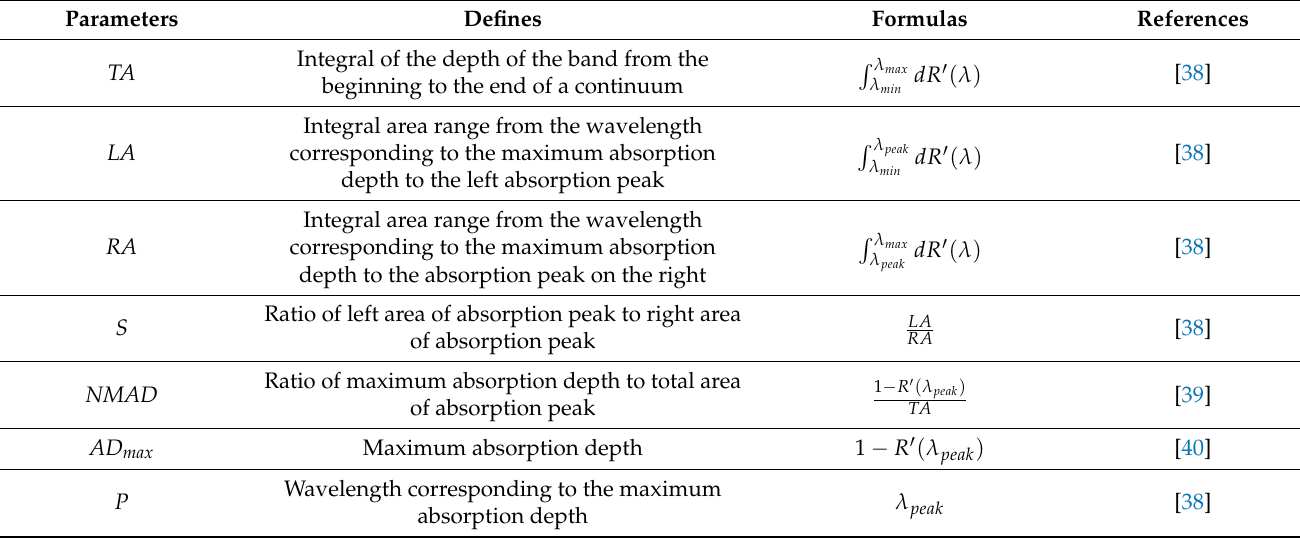
Table 3. Absorption parameters of continuum removal (CR)